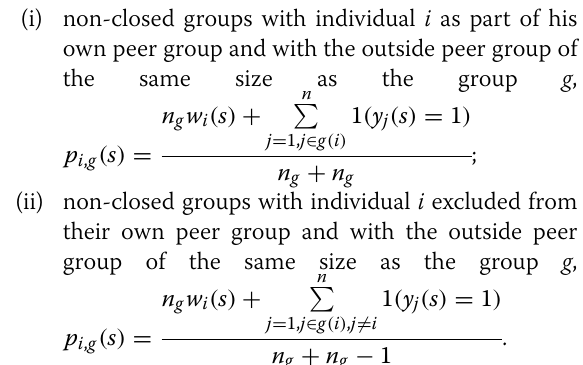
50 Monte Carlo simulations. Individuals excluded from their own peer group